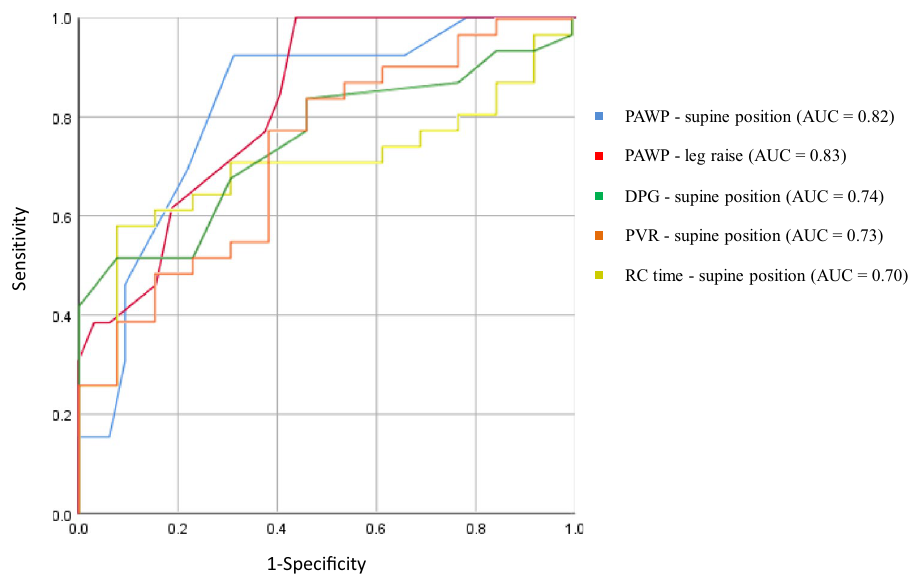
Figure 4. Receiver operating characteristic curves of PAWP at supine position, PAWP at leg raise, DPG at supine position, PVR at supine position and RC-time at supine position. AUC, area under the curve; DPG, diastolic pulmonary pressure gradient; PVR, pulmonary vascular resistance; RC time, pulmonary circulation time constant, PAWP, pulmonary artery wedge pressure